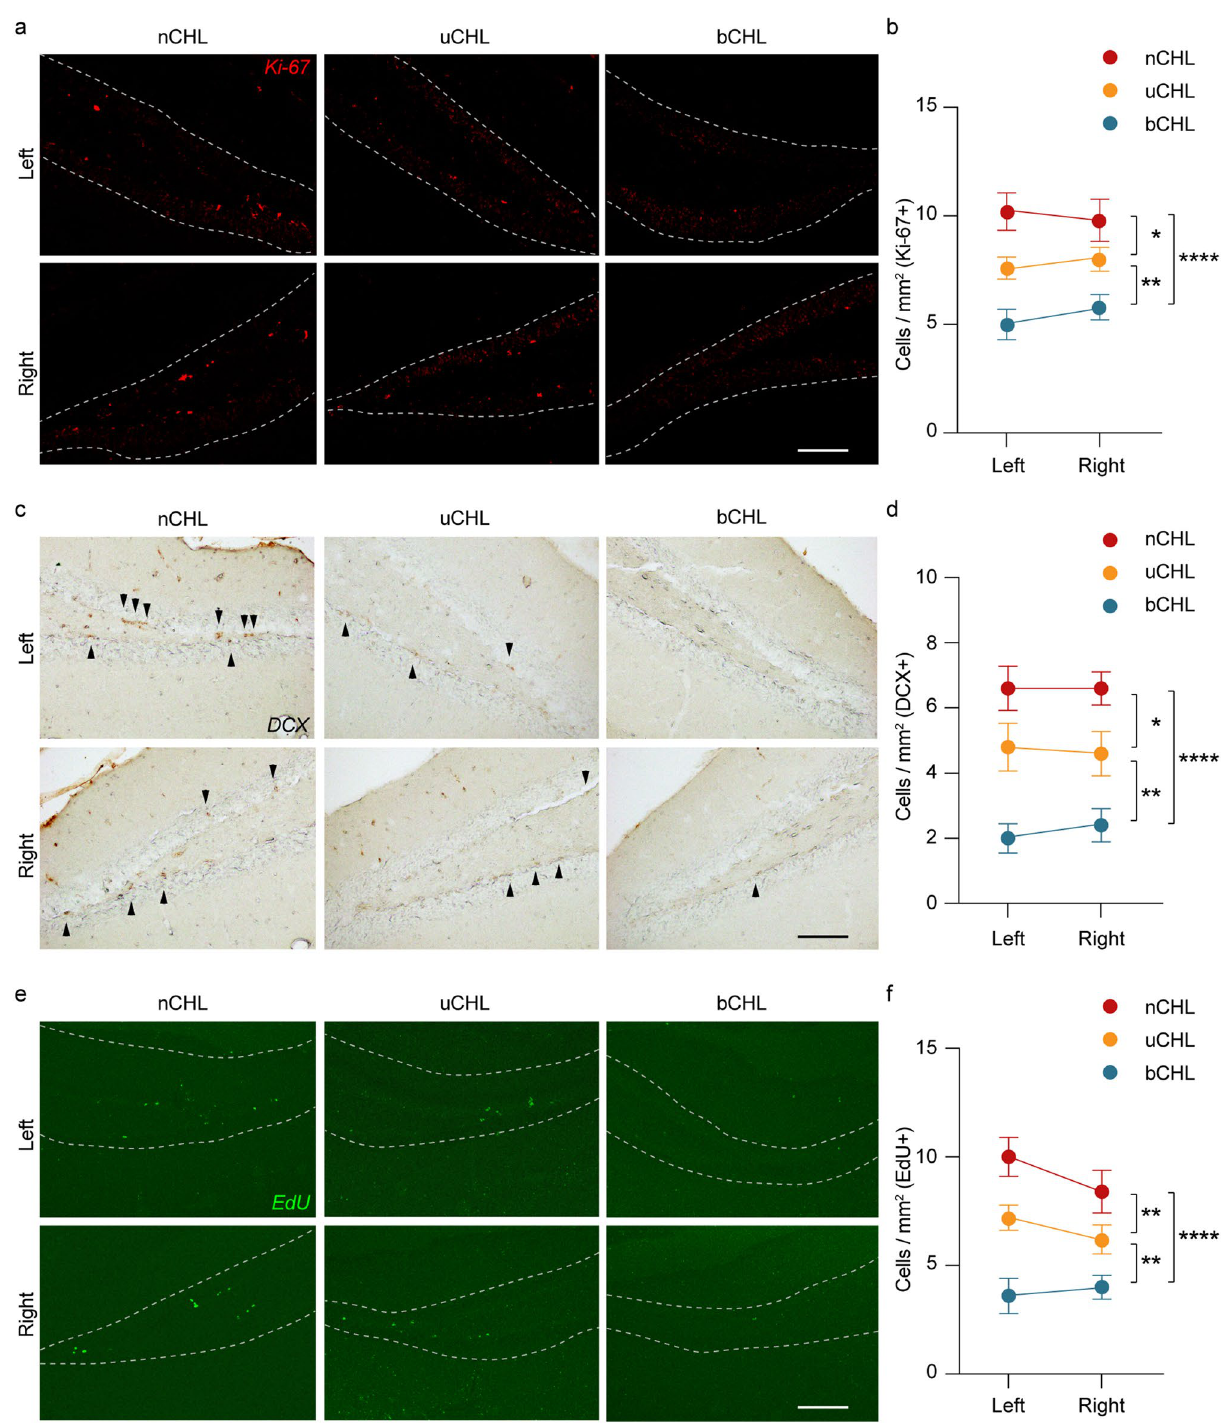
Figure 3. Auditory deprivation affected cell proliferation in the DG of the hippocampus. ( a , c , e ) Representative images of the hippocampus from each group of mice, immunostained for Ki-67, DCX, or EdU, five weeks after ear occlusion. Positive-staining cells were detected in the DG region of the hippocampus. ( b , d , f ) Summary of results regarding the number of Ki-67-positive, DCX-positive, and EdU-positive cells within the GCL. Significant differences among groups were observed. No significant differences between the ipsilateral and contralateral DG were detected across groups. The white dotted line indicates the border of the GCL. Scale bar indicates 100 μm. * p < 0.05, ** p < 0.01, **** p < 0.0001. DG, dentate gyrus; GCL, granule cell